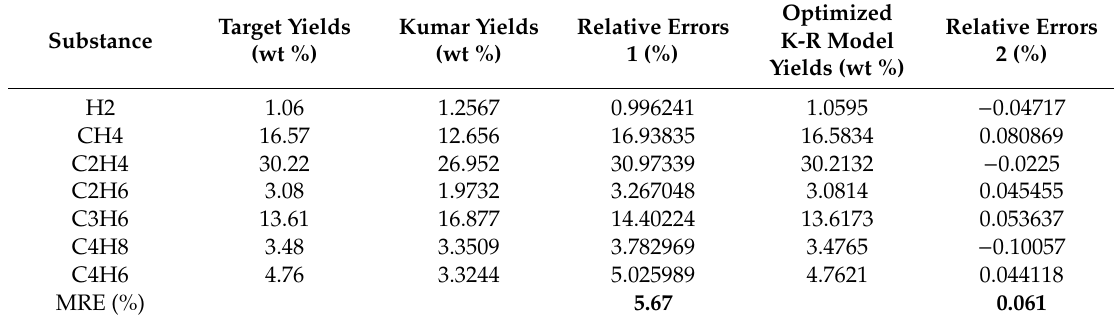
→ Is value of naphthas (1) and